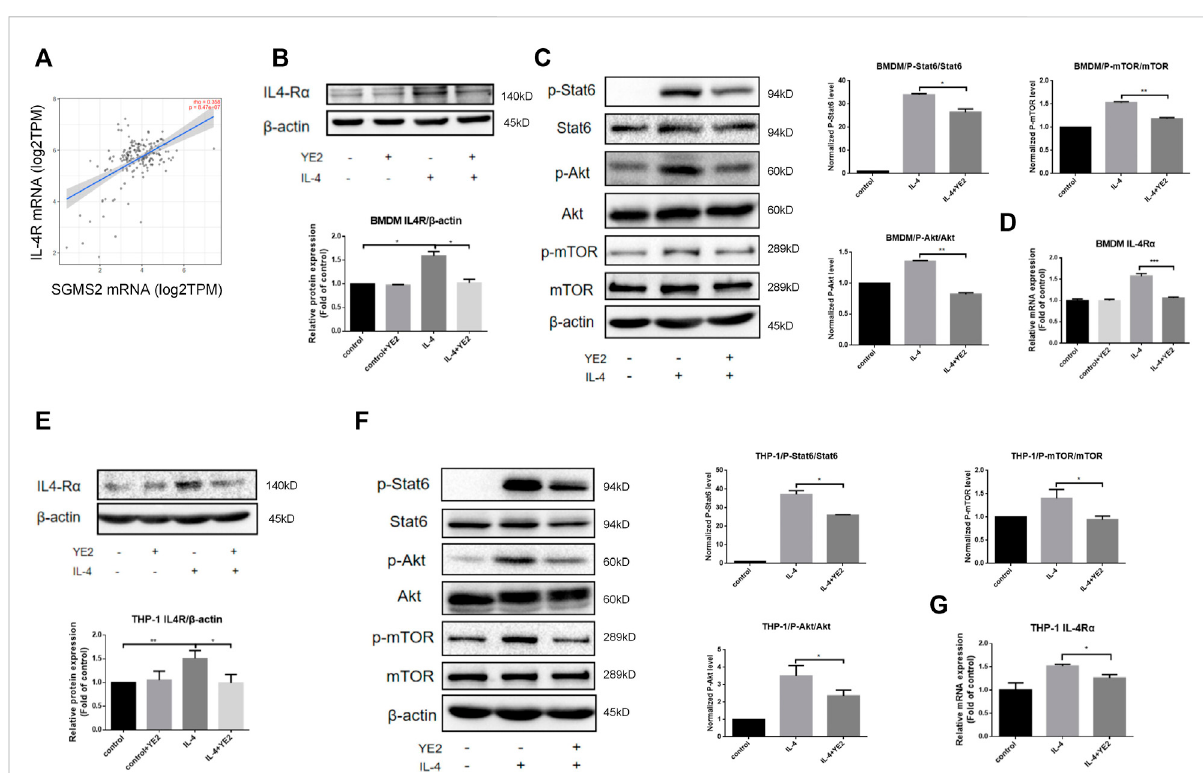
FIGURE 6 Themechanism ofSMS2 inhibitors ininhibitingIL-4-inducedM2polarization. (A) .TheexpressionofIL-4R α ispositivelycorrelatedwithSMS2 in pancreatic cancer. Immunoblotting was used to detect the expression of IL-4R α and downstream proteins in BMDM (B and C) and THP-1 (E and F) with or without YE2 48 h after IL-4 stimulation. The densitometry analysis data of BMDM (B and C) and THP-1 (E and F) was showed. Realtime